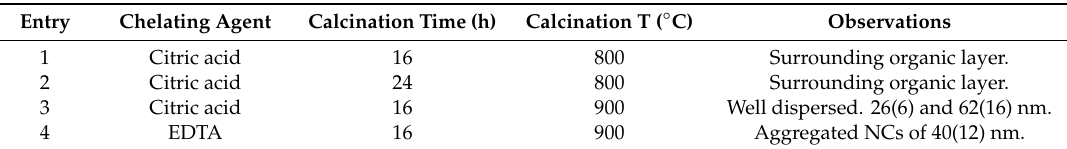
Table 2. Optimization parameters for the synthesis of Y 2 O 3 : Pr 3 + NCs by sol–gel Pechini method.